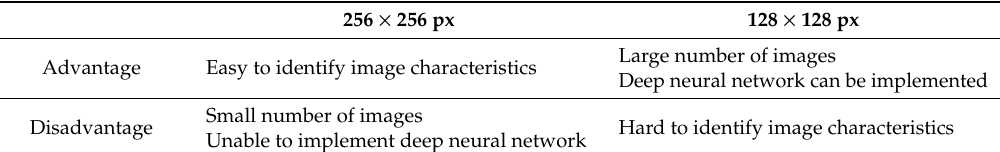
Table 2. (Dis) advantage by data size.